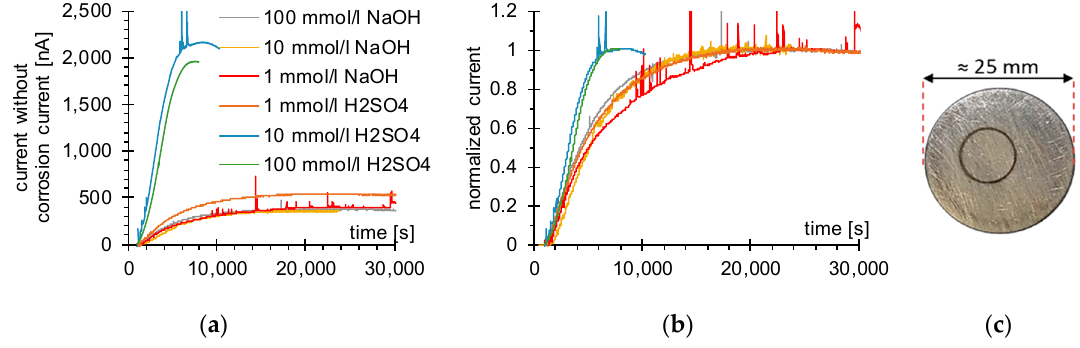
Figure 10. ( a ) Comparison of the measured currents, adjusted for corrosion current, at different pH-values on the loading side for the press-hardened 22MnB5, ( b ) normalized current of ( a ) and ( c ) sample after measurement.